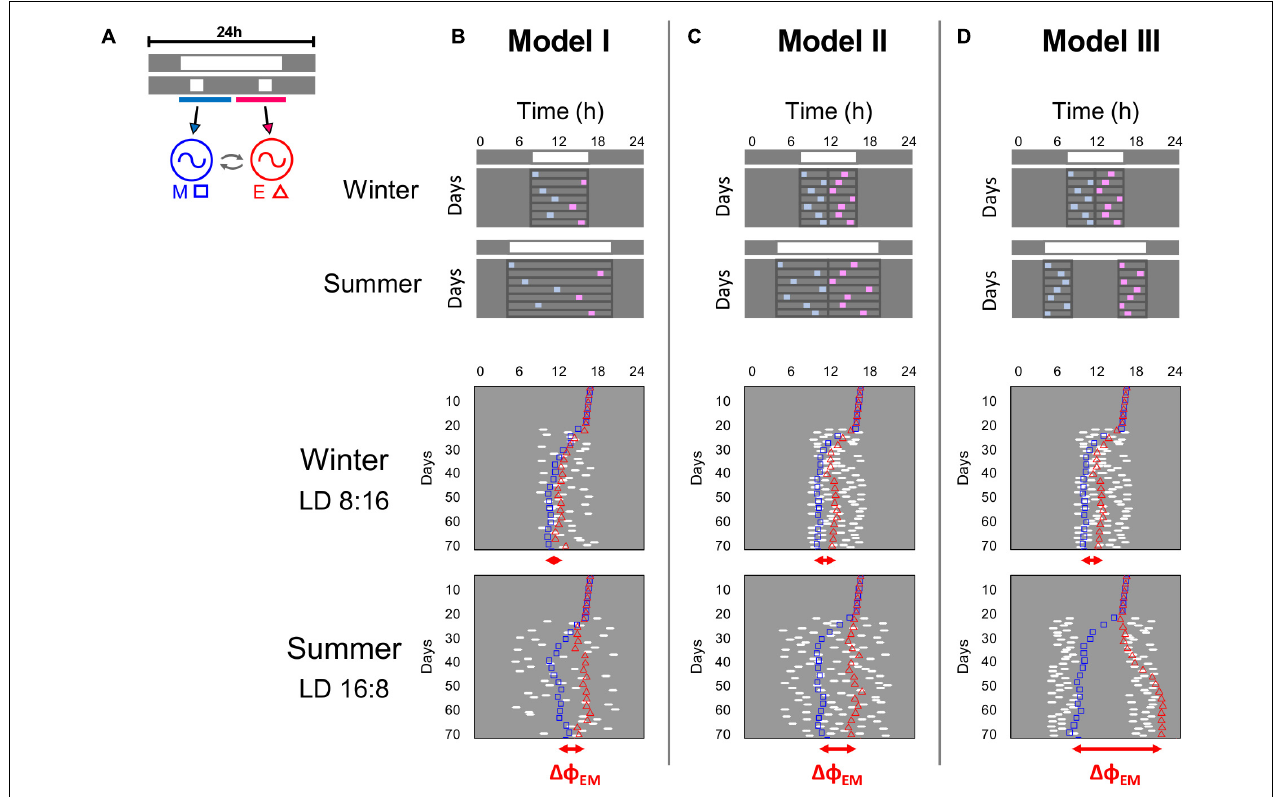
FIGURE 6 | A mathematical model was used to simulate 3 scenarios of light exposure at different seasons, and their impact on the synchronization of a two-oscillator model of the circadian clock. (A) Morning (M) and Evening (E) oscillators (circles), mutually coupled (curved arrows), were exposed to daily light pulses at random times within the photophase. The 24 h light regimen is represented by gray (dark) and white (light) bars. Upper bar: complete photoperiod. Lower bar: light exposure episodes (light pulses). Pulses between light onset and midday were applied to M (blue line and arrow), and pulses from midday to light offset were applied to E (pink line and arrow). (B–D) —Light exposure models I, II, and III, in winter and summer photoperiods. Upper panels: Schemes of the light pulse schedules. Gray/white bars depict the complete photoperiods and conceptual schemes represent the light exposure episodes along consecutive days, with blue and pink squares indicating light pulses applied to M and E, respectively. Lines around the light pulses on each day delimit the distribution interval of the pulses. Lower panels: Actograms illustrate the model dynamics on consecutive days under the light pulses (white marks). Colored symbols depict the reference phases of M (blue squares) and E (red triangles). Oscillator symbols are plotted only every third day for better visualization. Below the actograms, red horizontal arrows show the average (cid:49)(cid:56) EM on the last 20 days. For details on the light exposure models, see main text. For model parameters see section “Materials and